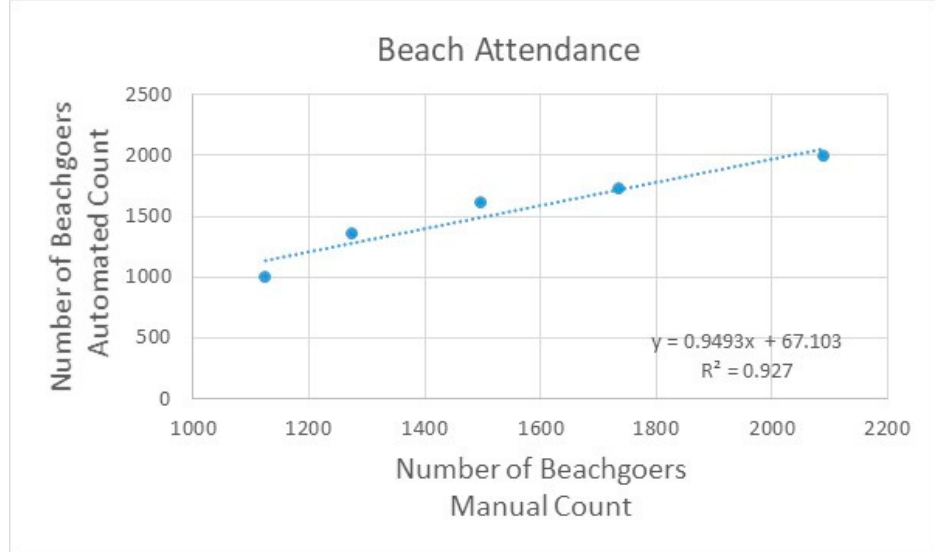
Figure 3. Comparison between manual and automated count of beach visitors.